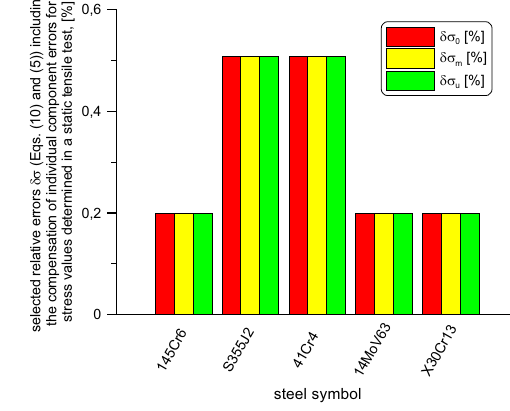
Figure 11: Comparison of the relative errors δσ including the com - pensation for individual errors of component quantities, for selected stress values using equations ( 10 ) and ( 5 )